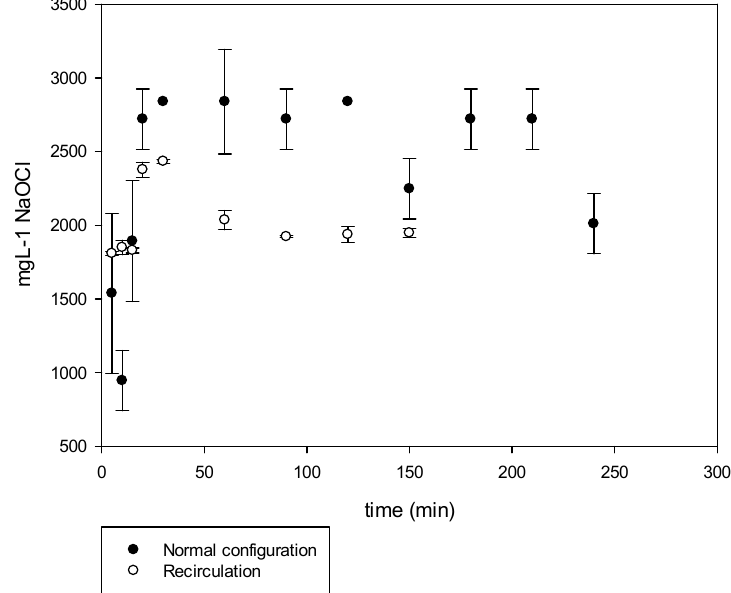
Figure 7. Hypochlorite production in normal and recirculation configuration.